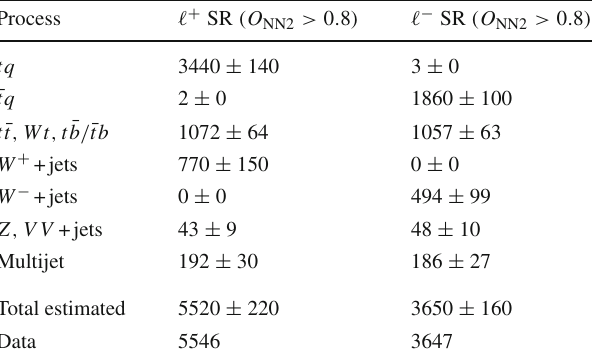
Table 8 Predicted (post-fit) and observed event yields for the signal region (SR), after the requirement on the second neural network dis- criminant, O NN2 > 0 . 8. The multijet background prediction is obtained from the fit to the E miss distribution described in Sect. 6, while all the T otherpredictionsanduncertaintiesaretakenfromthetotalcross-section measurement. An uncertainty of 0 means that the value is < 0 .